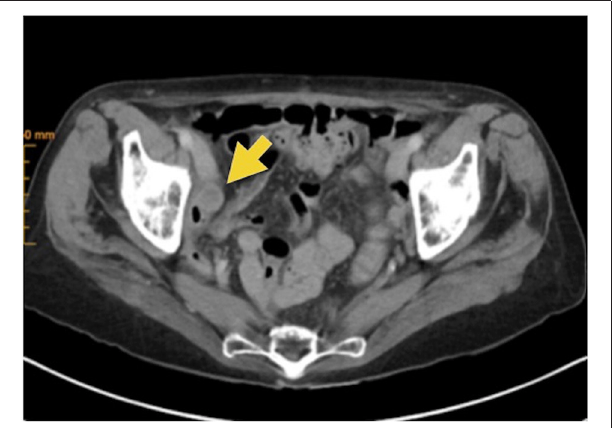
FIGURE 3 | Situs intraoperatively: metastatic suspected lesion (1), external iliac vein